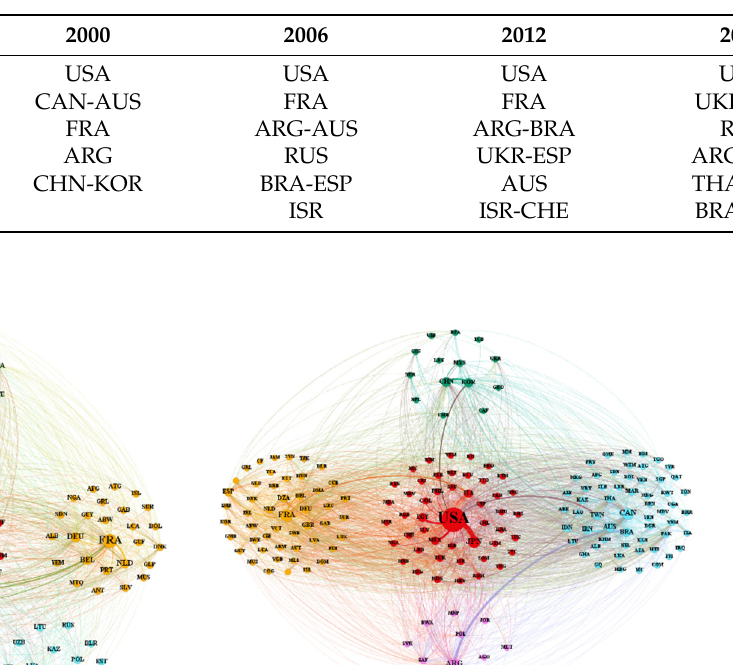
Table 2. Community detection in 1994, 2000, 2006, 2012, and 2018.